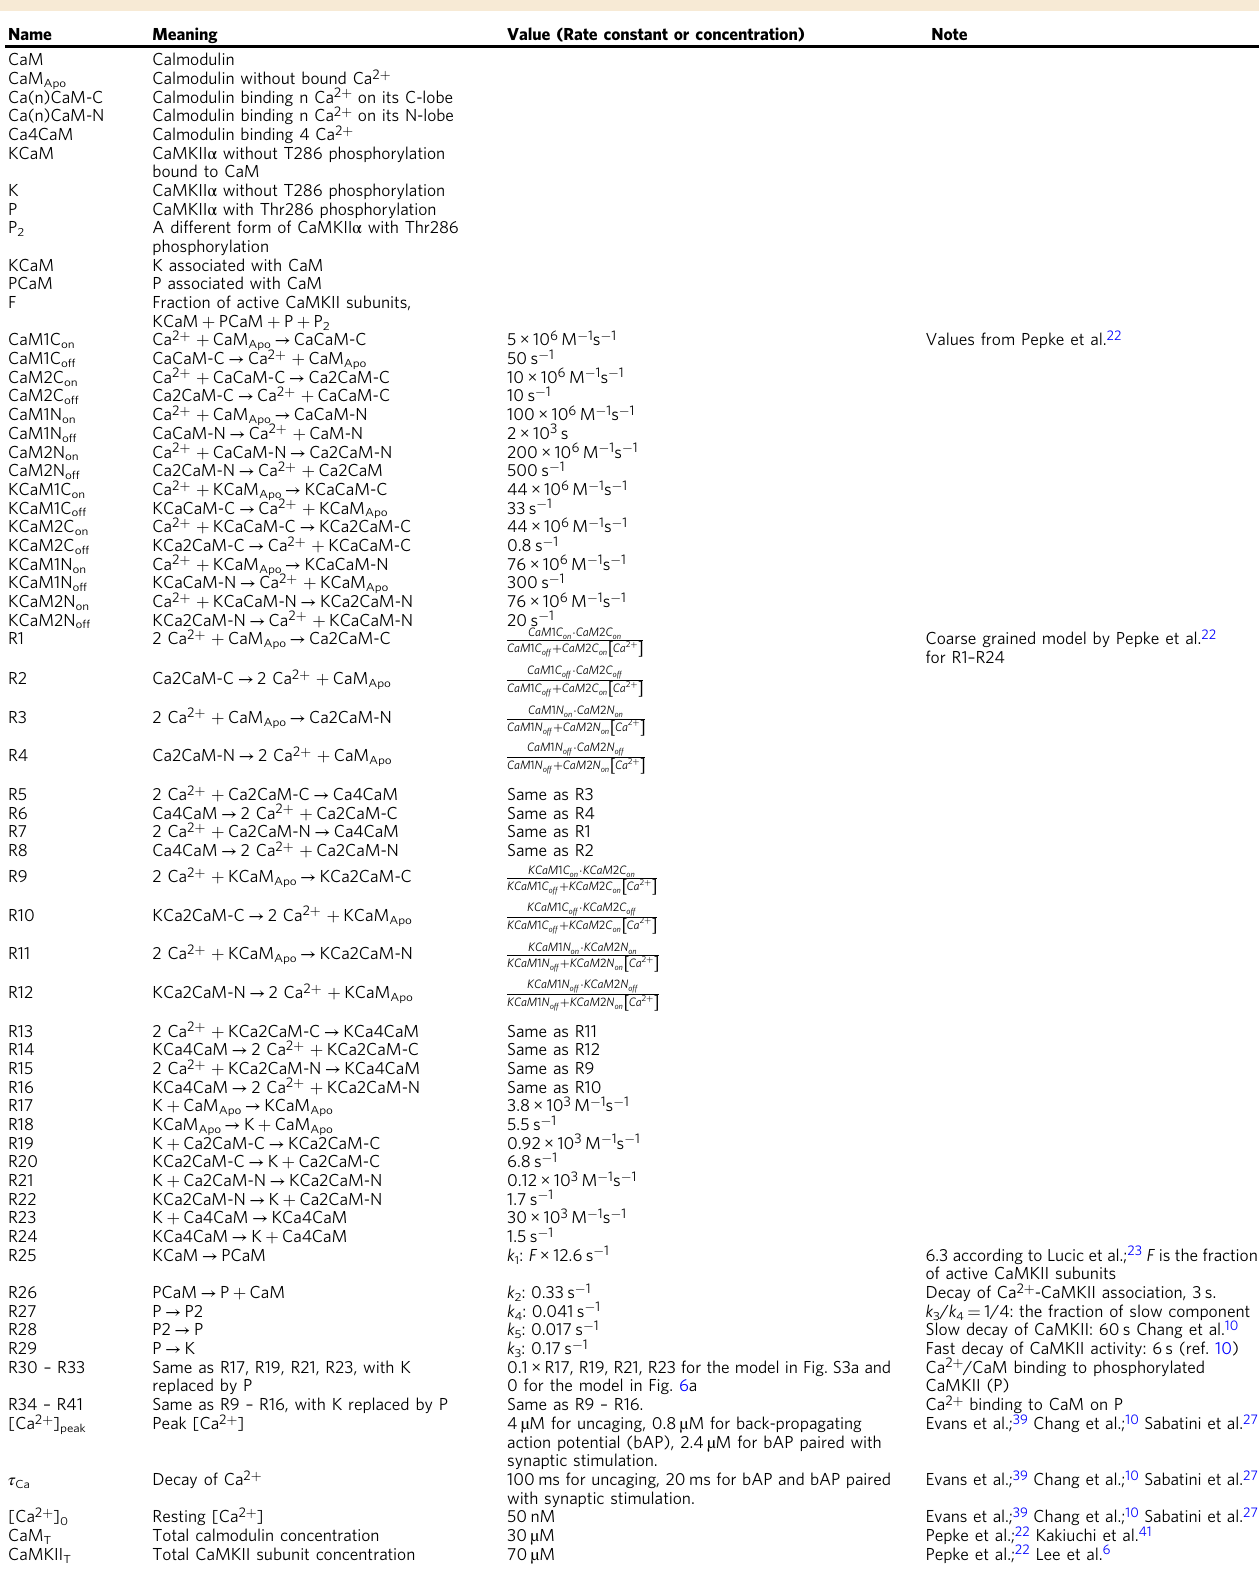
Table 1 List of parameters used for